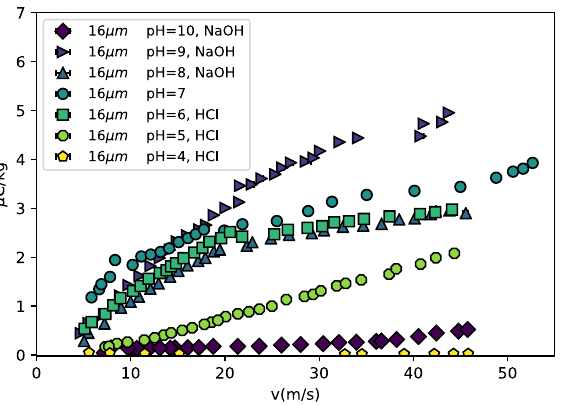
Figure 4. Charging efficiency for different pH levels in water. For very high or low pH the charging efficiency decreases, as can be expected from the increase in conductivity. For pH=9 however, the charging efficiency seems to be the highest. As silicon dioxide is a very weak acid (orthosilicic acid ), the zeta potential increases with higher pH 23 , which easily explains the optimal pH is higher than